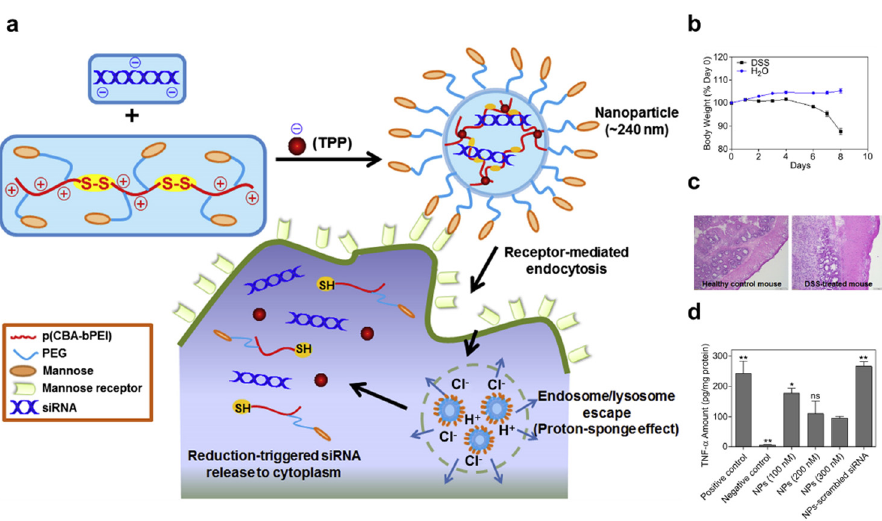
Figure 4. Active-targeting functionalized polyplex-based nanomaterials. ( a ): Schematic illustration of TPP-PPM/siRNA nanoparticle (NP) formation, macrophage-targeting delivery, and release of siRNAs to the cytoplasm ( b ): Changes in body weight over time in mice treated with 3% DSS in drinking water. ( c ): Hematoxylin − and eosin-stained colon sections from healthy control and DSS-treated mice sacrificed on day 8. ( d ): Inhibition of TNF- α secretion by siTNF-loaded triphosphate-cationic polymer nanoparticles (TPP-PPM/siTNF NPs) (weight ratio, 40:1) at different siTNF concentrations (100 nm, 200 nm, and 300 nm). Statistical p -values: No significance: ns; * p < 0.05, ** p < 0.01. Reproduced with permission [98]. 2013, Elsevier.